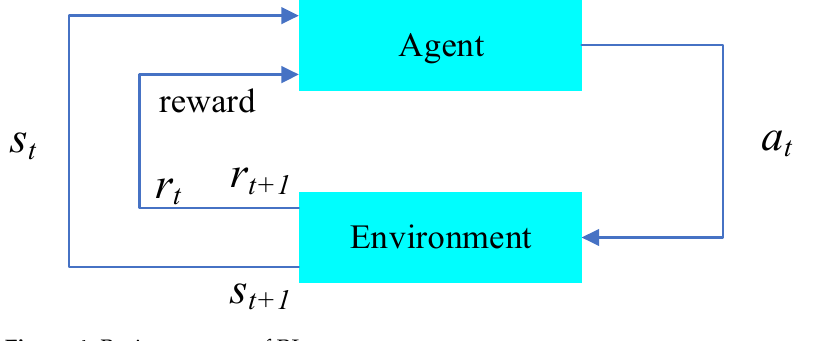
Figure 4. Basic structure of RL.